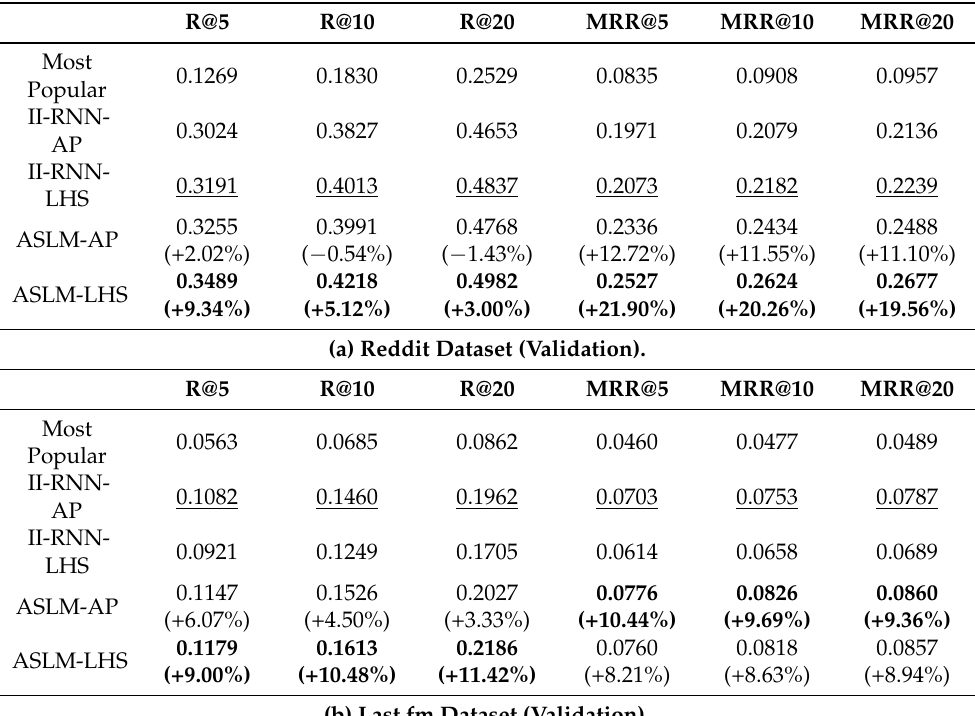
Table 4. Group A: Recall and MRR scores for the ASLM models and the baselines for the validation sets in Reddit and Last.fm datasets.